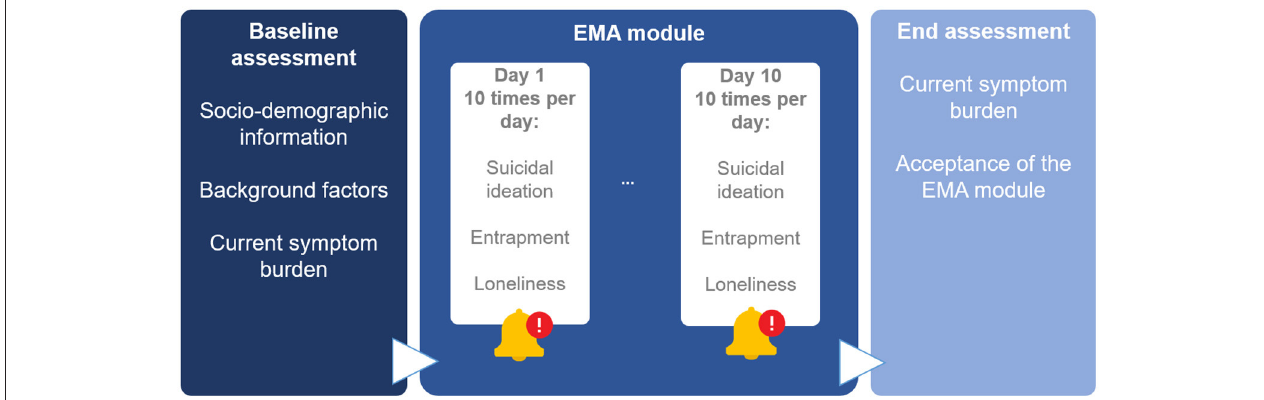
FIGURE 2 | Depiction of assessments within the project TempRes. The signal-contingent Ecological Momentary Assessment (EMA) module contains ten assessments per day over a course of 10 days, resulting in up to 100 single assessments per person. Displayed are the main constructs of interest in the context of the primary research question. Beyond these, the EMA module also includes assessments of mood and context